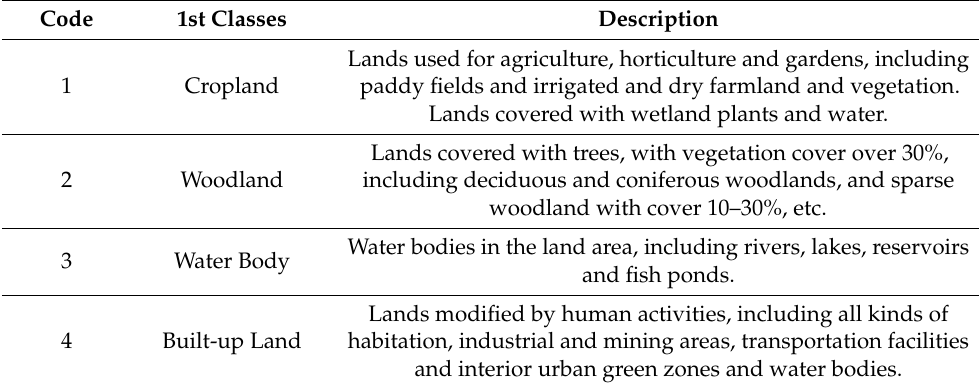
Table 1. The category of land use/land cover in